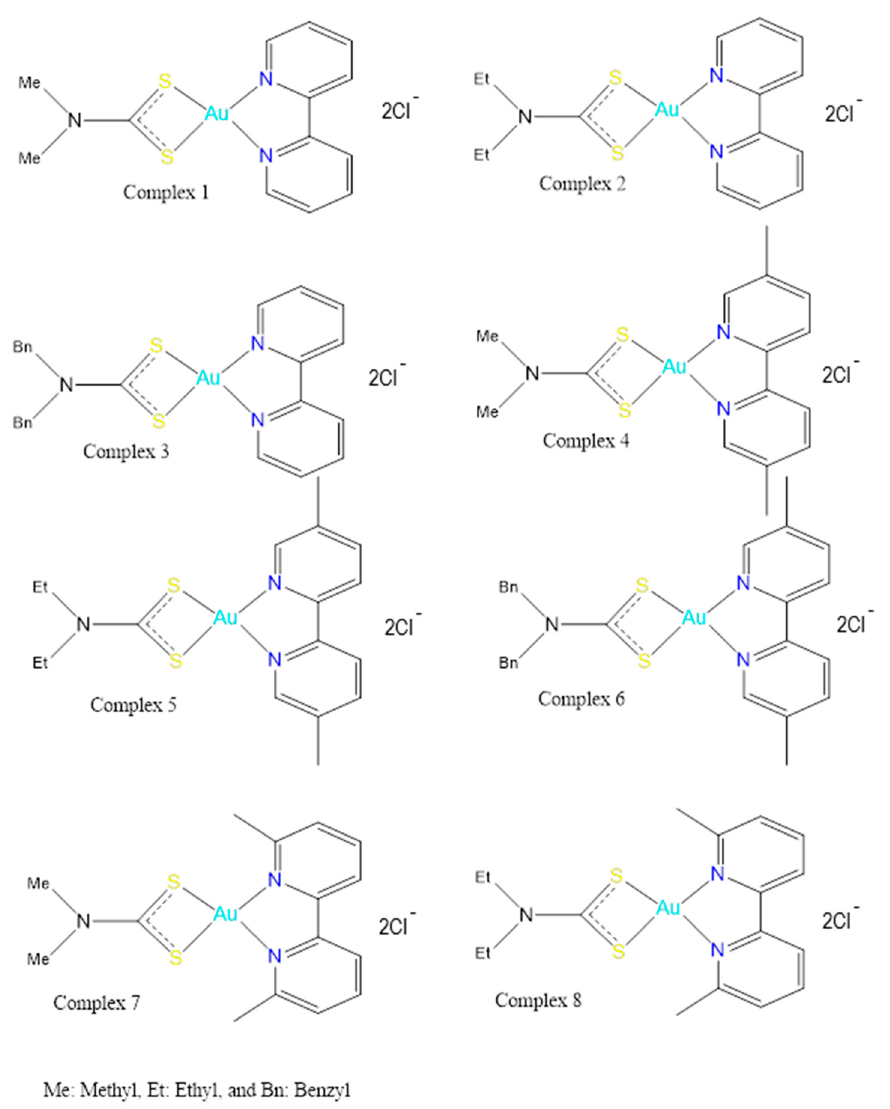
Figure 1. The bipyridine gold (III) dithiocarbamate-containing complexes (1–8) .